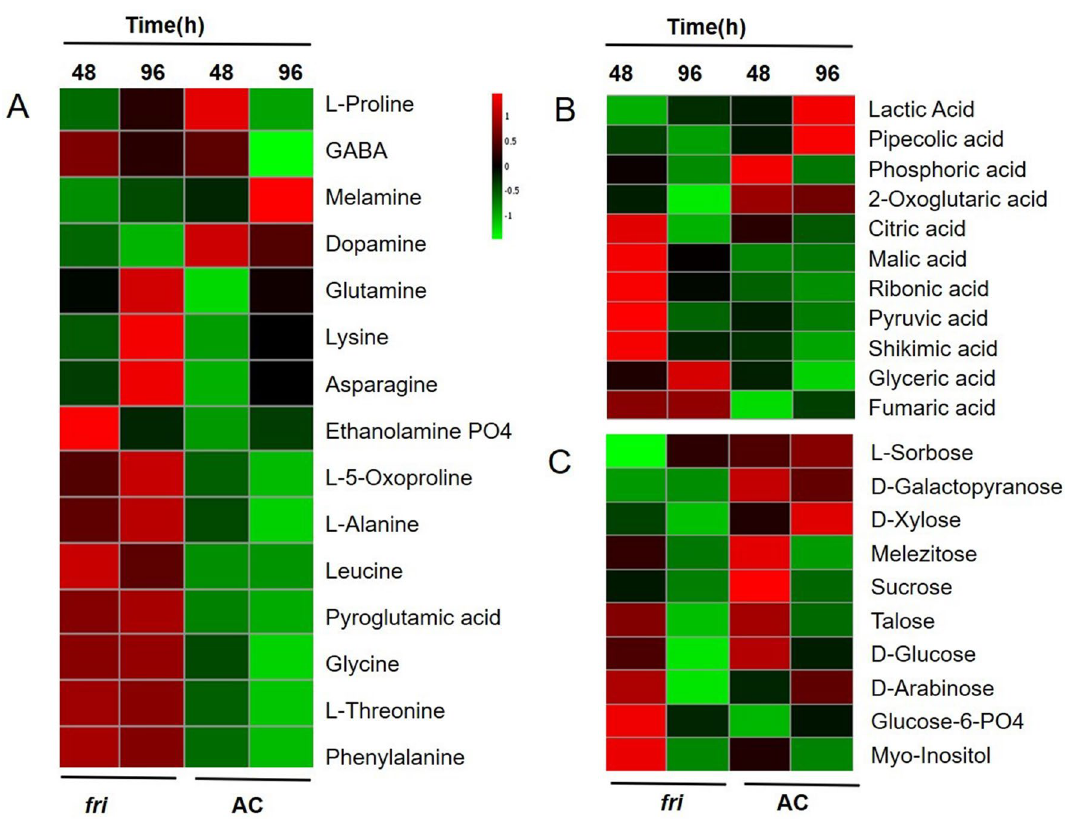
Figure 4. Metabolomic profiling of fri mutant to validate the findings from discovery proteomics. Heat map showing differential expression of ( A ) amino acids ( B ) organic acids ( C ) sugars in the seedlings treated under FR light compared to